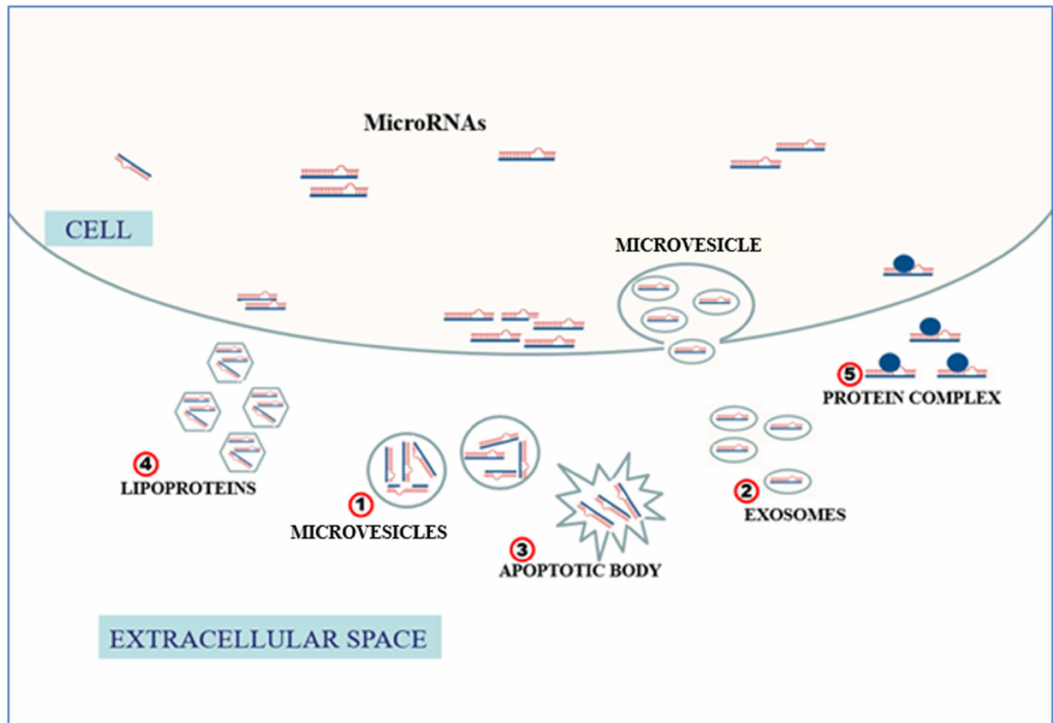
Figure 2. Release of miRNA to the extracellular compartment. Mature miRNAs are transported out of the cell by (1) enwrapping into microvesicles, (2) selective incorporation into exosomes, (3) apoptotic bodies, (4) coupling with high- density lipoproteins and (5) protein complexes such as AGO to be released into the extracellular environment or other